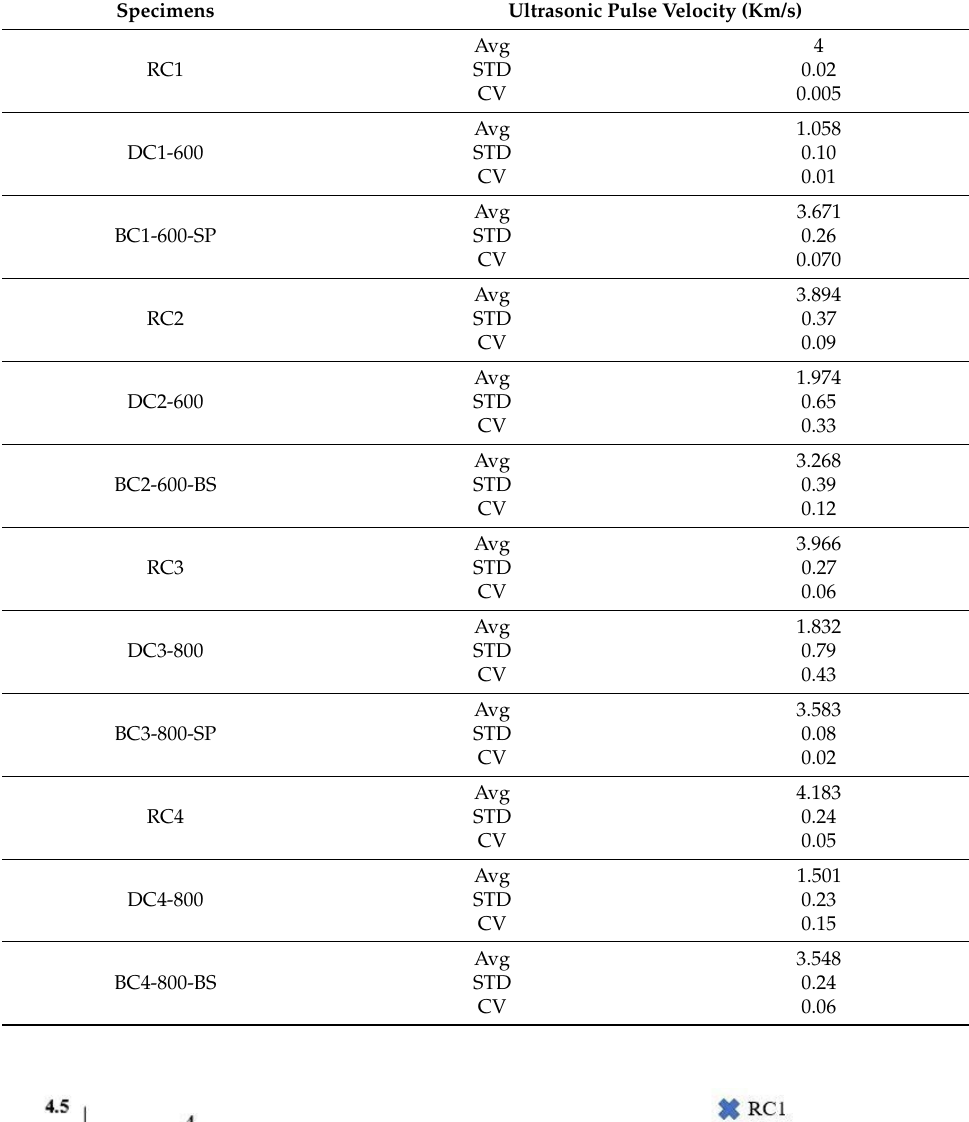
Table 4. Results of ultrasonic pulse velocity.